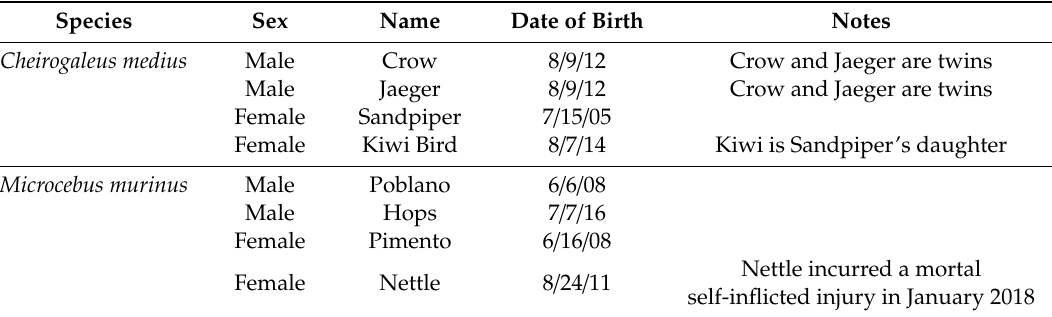
self-inflicted injury in January